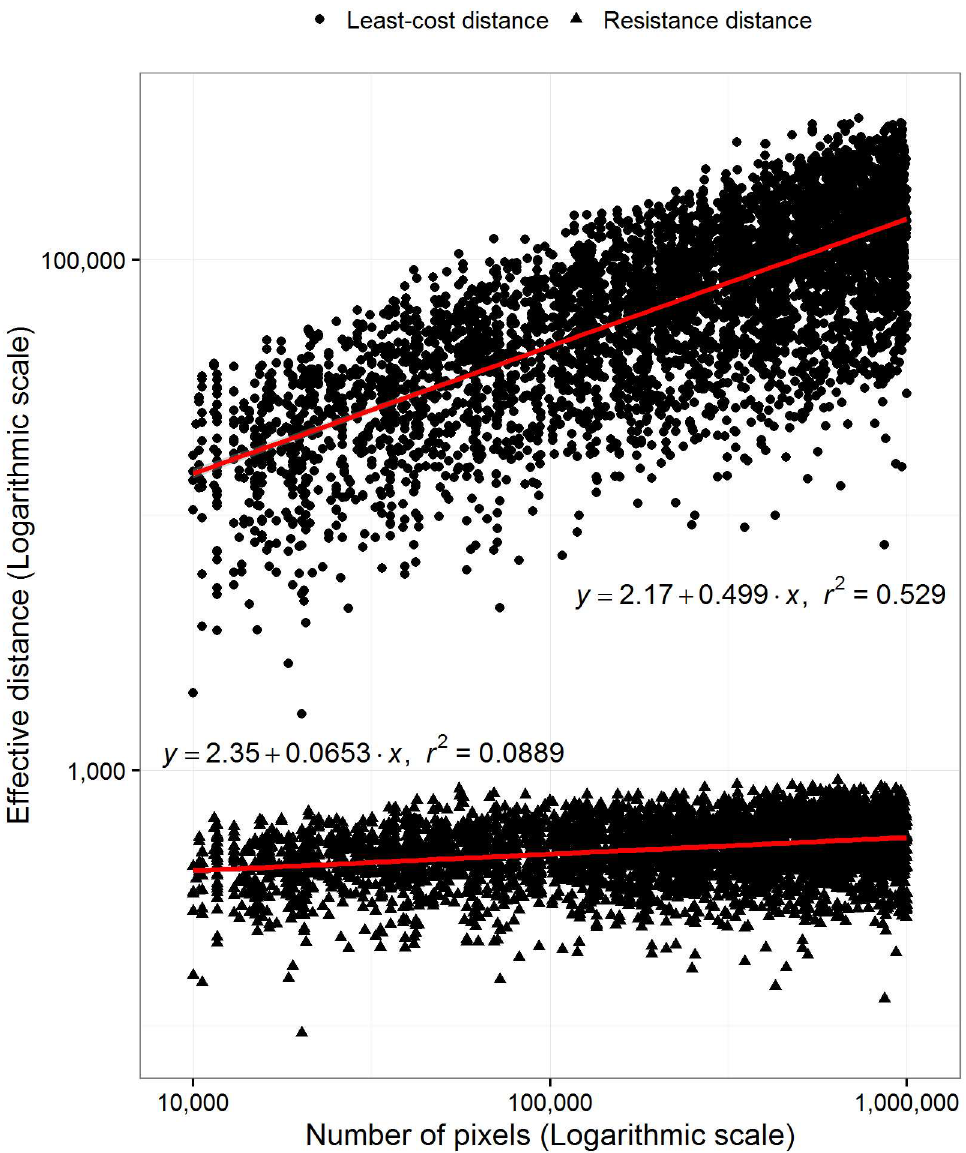
Fig 4. The effect of the number of pixels representing a landscape. The least-cost and resistancedistance in relation with the varyingnumber of pixels for a subset of 5,000 random paths sampledfrom 1,000 deferent landscapes with varying degreesof spatial autocorrelation and number of pixels representingthe landscape. Both axes are on a logarithmic scale. In this case both the responseand explanatoryvariableswere log- transformed to calculatethe linear model. Landscapesize (number of pixels) is varied from 10 thousandto 1 millionpixels.